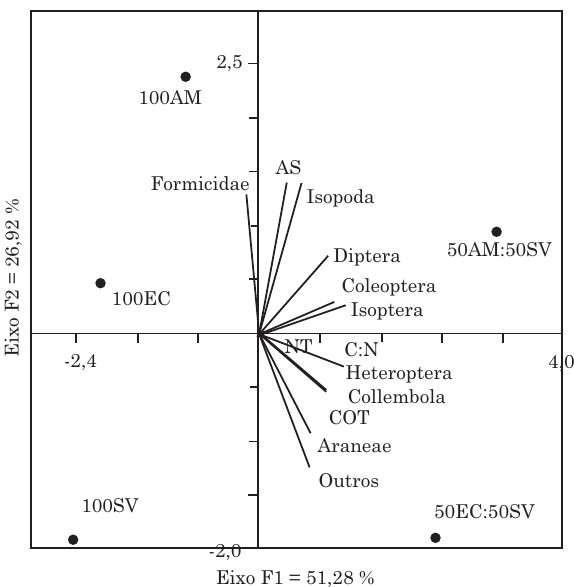
Figura 2. Análise de componentes principais (ACP) para abundância de grupos da fauna do solo, do carbono orgânico total (COT), do nitrogênio total (NT), da relação carbono:nitrogênio (C:N) e do aporte de serapilheira (AS) em plantios puros e consorciados de Eucalyptus camalsulensis (EC) e Acacia mangium (AM) com Sesbania virgata (SV), em cava de extração de